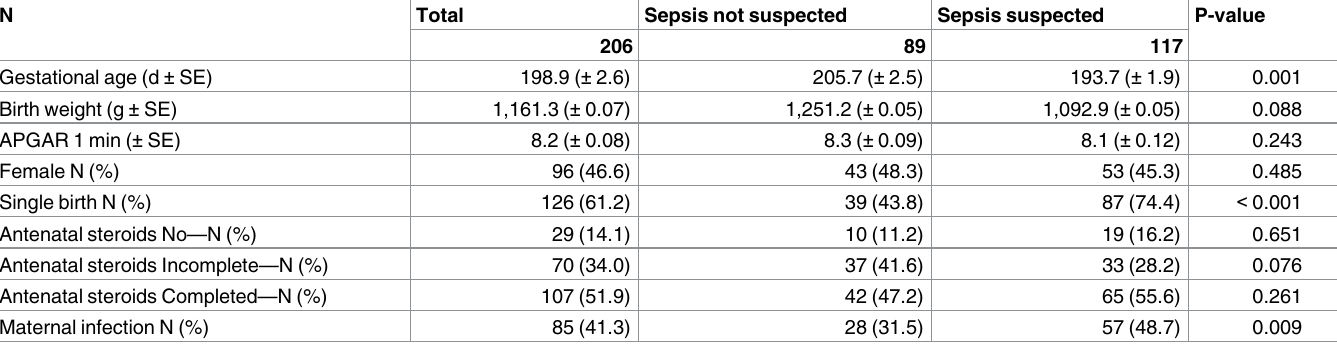
Table 1. Baseline characteristics of study